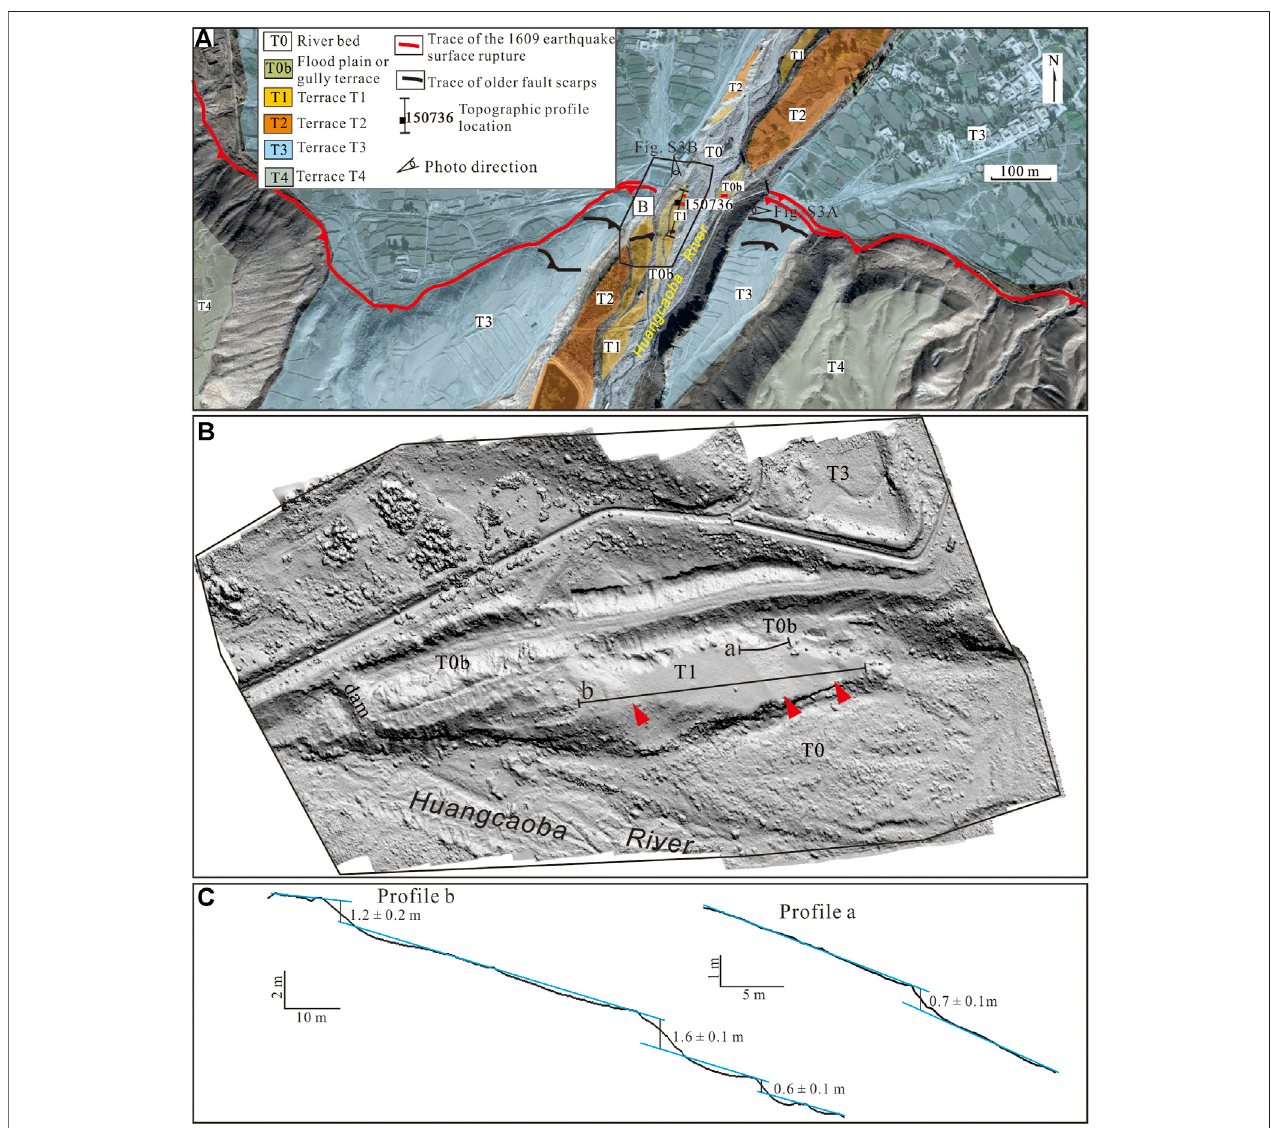
FIGURE8| Topographicfeatures ofthe1609earthquakesurfacerupture attheHuangcaoba site. (A) Surfacerupture map (B) HillshadeDEMextractedfrom UAV aerial photography of the estuary of the Huangcaoba River. (C) Topographic pro fi les across portions of 1609 rupture traces.